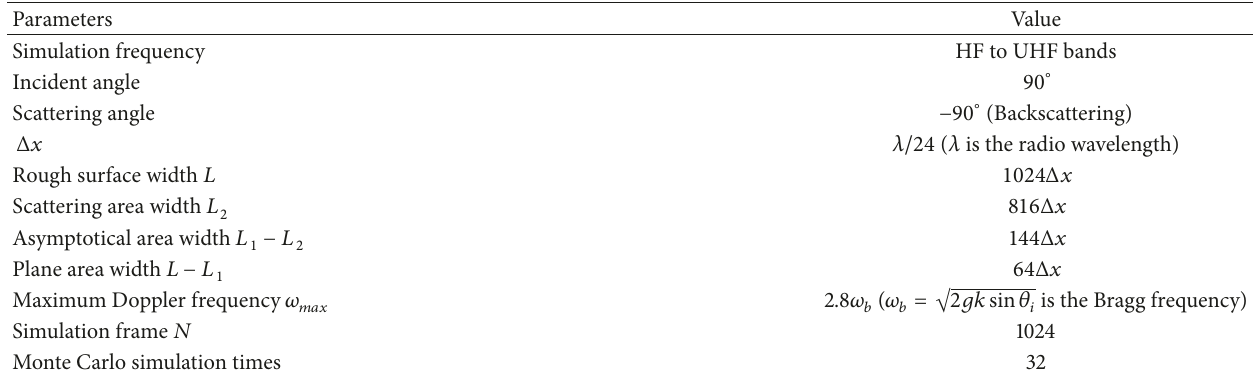
Figure 4: Sketch map of the Doppler spectrum simulation. Table 1: Simulation conditions.